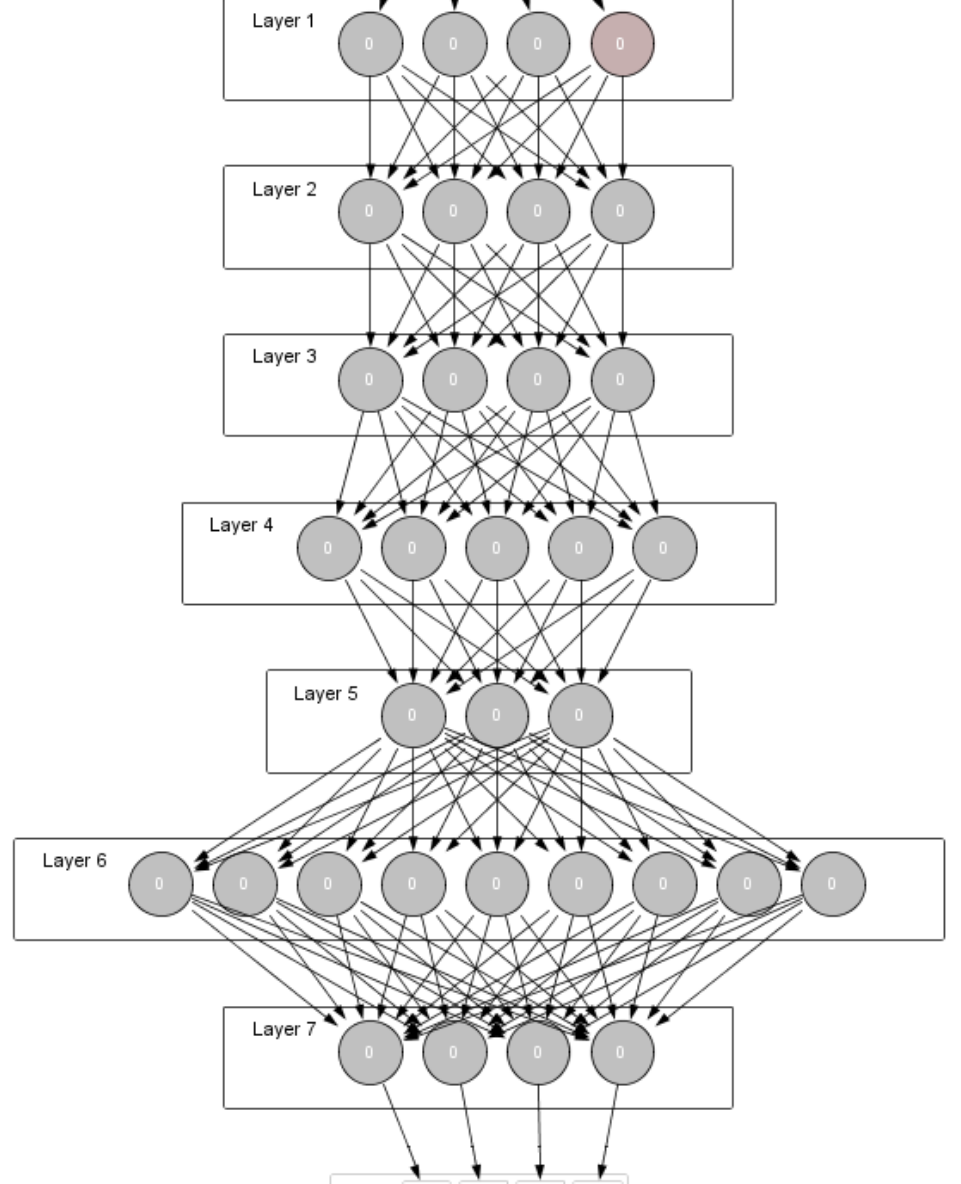
Figure 4: ANN architecture implemented in NeurophStudio